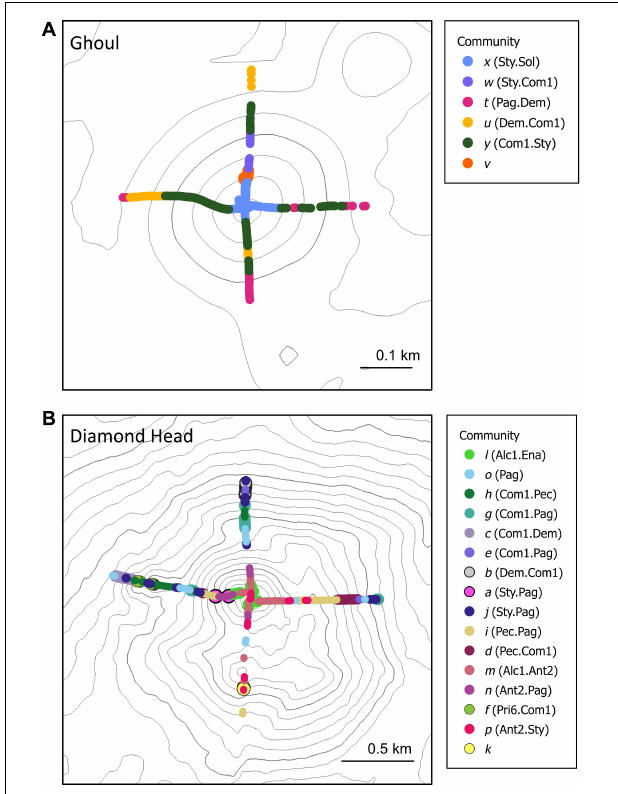
FIGURE 4 | Spatial distribution of benthic communities identified by cluster and SIMPROF analysis on (A) Ghoul and (B) Diamond Head. Each point represents an individual image. Contour lines represent 20 m depth intervals.